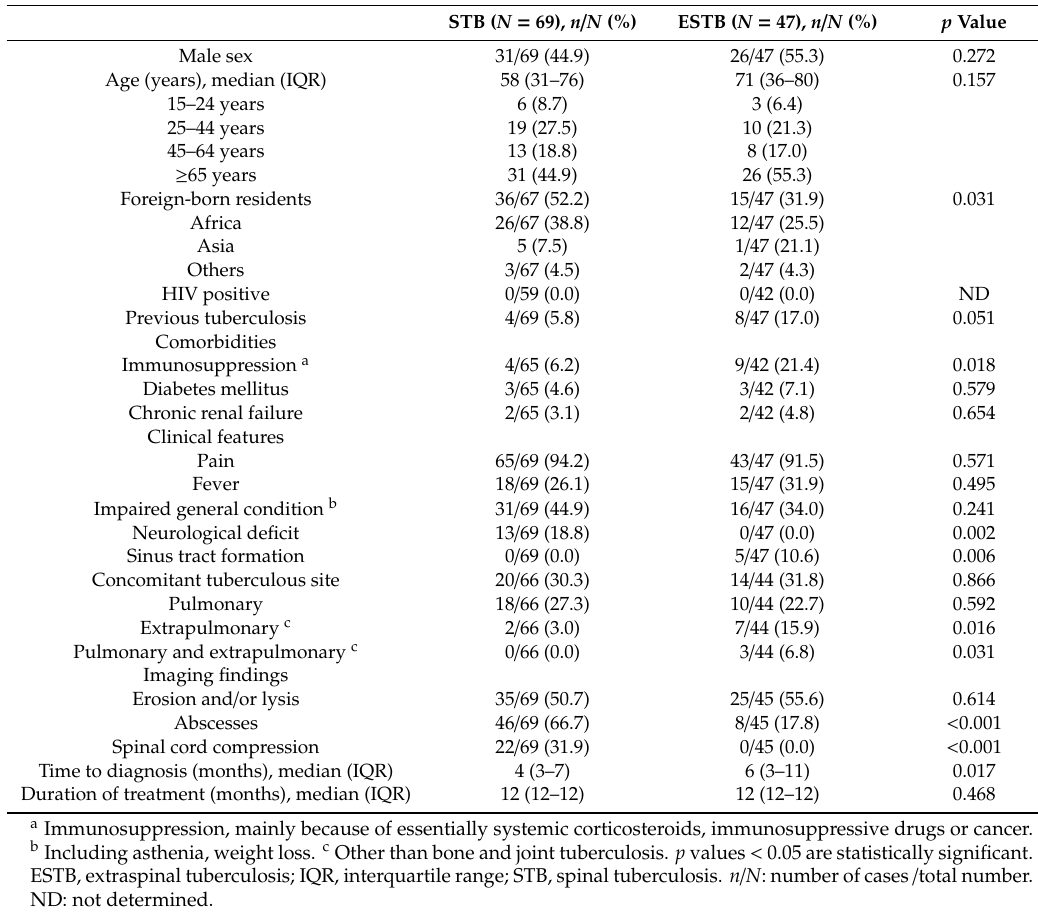
Table 1. Characteristics of patients with bone and joint tuberculosis.